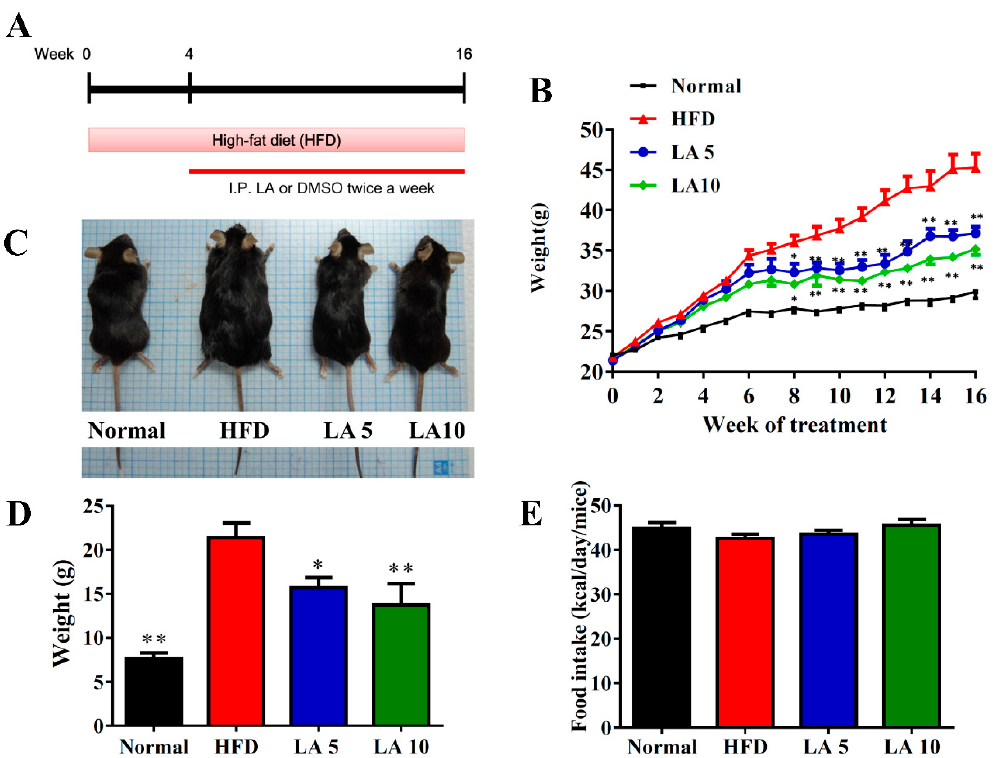
Figure 1. Licochalcone A (LA) reduced body weight in high-fat diet (HFD)-induced obese mice. ( A ) Male mice were fed an HFD (containing 60% fat) for 16 weeks, and administered DMSO, 5 mg / kg licochalcone A (LA5), or 10 mg / kg licochalcone A (LA10) by intraperitoneal injection (I.P.) twice a week from week 4 to 16. ( B ) Weight gain was measured for 16 weeks. ( C ) The appearance of the animal and ( D ) weight gain measured in the last week. ( E ) Food intake monitored each day. Data are presented as the mean ± SEM; n = 12. * p < 0.05, ** p < 0.01 compared with mice with HFD-induced obesity.